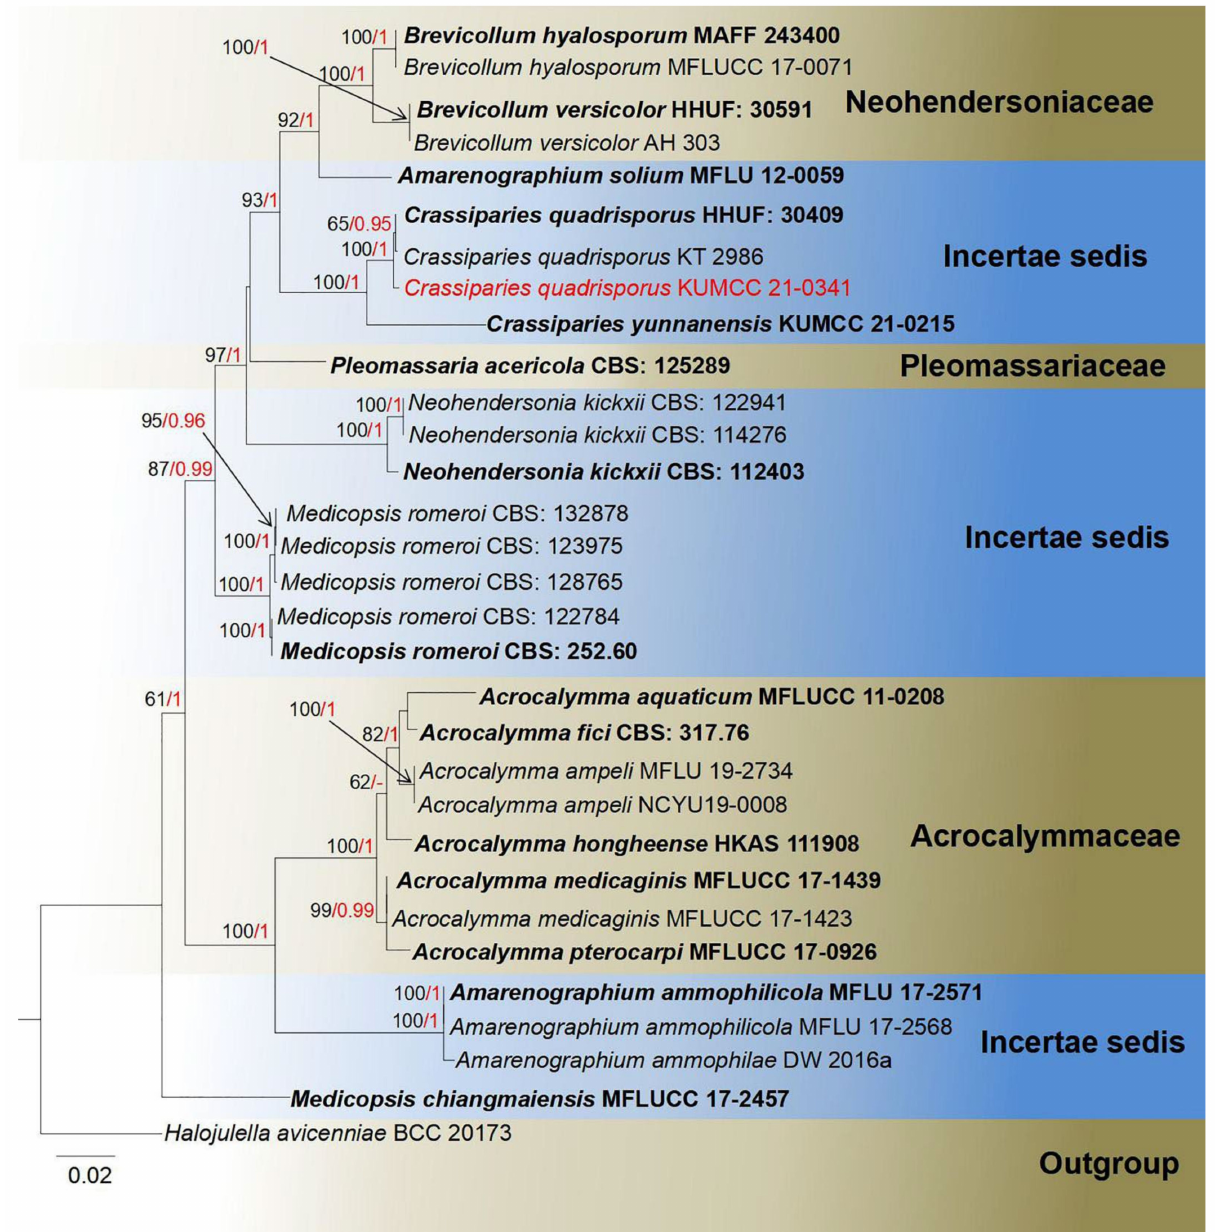
Figure 17. Phylogram generated from maximum likelihood analysis based on a combined LSU, SSU, ITS, and tef1- α sequence datasets. Related sequences were taken from Li et al. [69]. The 31 strains are included in the combined gene analyses’ 3240 total characters, including gaps (LSU: 1–888 bp, SSU: 889–1781 bp, ITS: 1782–2329 bp, tef1- α : 2330–3240 bp). Tree topology of the ML analysis was similar to the BI. The matrix had distinct alignment patterns, with the final ML optimization likelihood value of − 11,009.361241 (ln). All free model parameters were estimated by RAxML model, with 702 distinct alignment patterns and 19.72% undetermined characters or gaps. Estimated base frequencies were as follows: A = 0.242404, C = 0.240804, G = 0.271065, T = 0.245727, with substitution rates AC = 1.229245, AG = 2.590965, AT = 1.688351, CG = 0.503600, CT = 6.760365, GT = 1.000000. The gamma distribution shape parameter alpha = 0.671776, and the Tree-Length = 0.622587. The final average standard deviation of split frequencies at the end of total MCMC generations was calculated as 0.009945 in BI analysis. The species determined in this study are indicated in red. Bootstrap values greater than 60% (ML, left) and Bayesian posterior probabilities (BI, right) greater than 0.95 are given at the nodes; hyphens (-) represent values less than 60% in ML/0.95 in